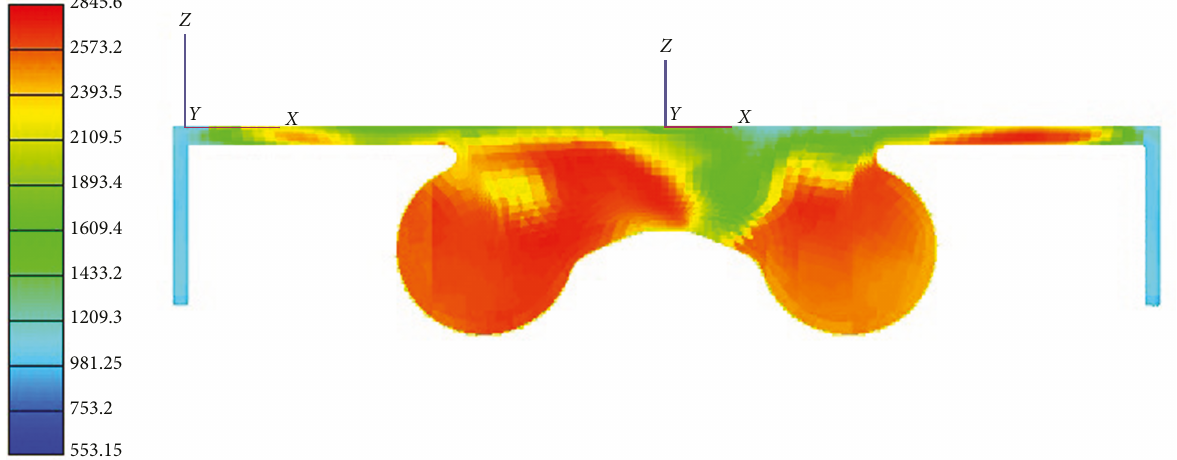
Figure 5: The temperature fi eld under 730 ° CA of program 1.